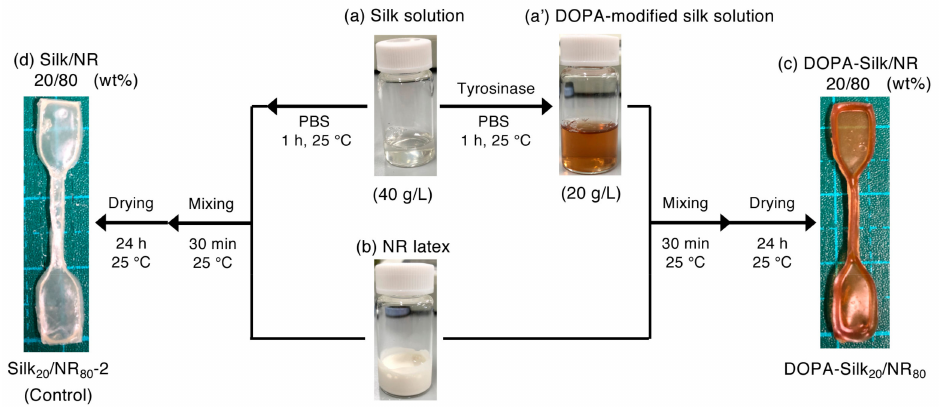
Figure 8. Sample preparation protocol of the DOPA-silk / NR composite and its appearance. The 20 wt% DOPA-modified silk solution (20 g / L) ( a’ ) was prepared from silk solution ( a ) and subsequently mixed with NR latex ( b ) and stirred for 30 min at 25 ◦ C. The mixture was poured into a silicon mold and dried for 24 h at 25 ◦ C, to give DOPA-silk 20 / NR 80 ( c ). The control sample, silk 20 / NR 80 -2, was prepared in the same manner without the addition of tyrosinase ( d ). Note that the silk concentration for the preparation of DOPA-silk 20 / NR 80 and silk 20 / NR 80 -2 di ff ered from that of silk 20 / NR 80